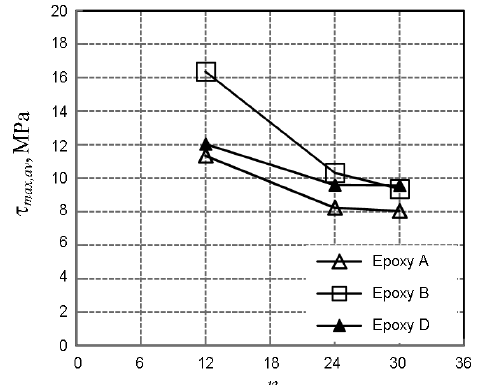
Fig. 11. Effect of epoxy type and bond length for specimens with CFRP bars on τ max,av ( n = L b / d b )